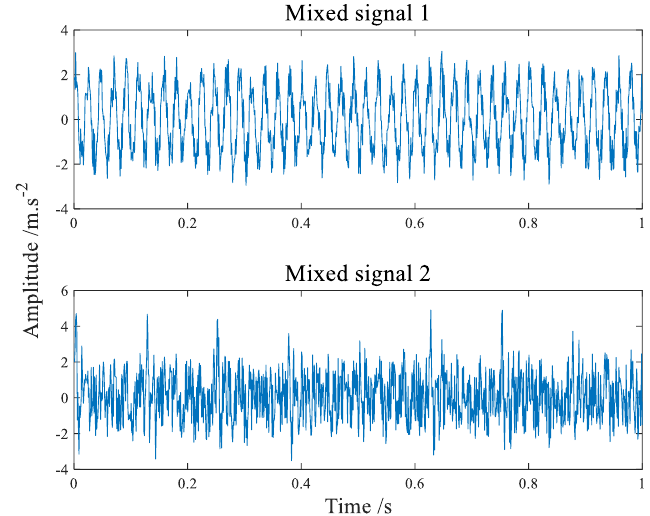
Figure 5. The amplitude spectrum of simulation signals.